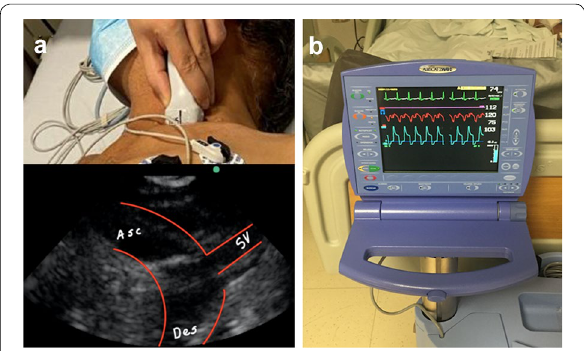
Fig. 5 a Supraclavicular approach with a phased array transducer, left supraclavicular window, ascending (Asc) and descending (Des) aorta and the left subclavian artery (SV). b IAoBC connected to the console and with adequate